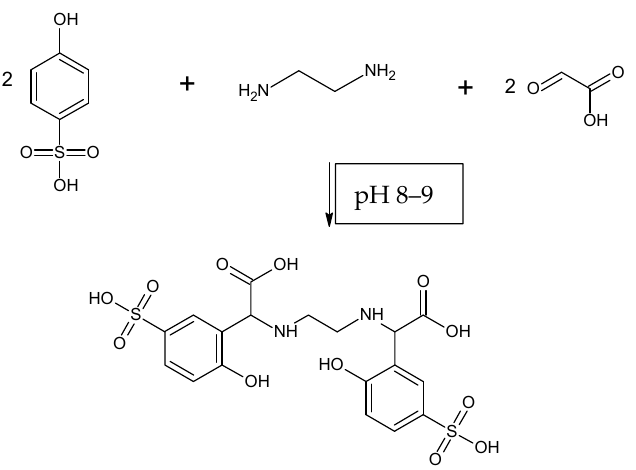
Figure 16. Reaction scheme for the preparation of EDDHSA using the Mannich reaction.